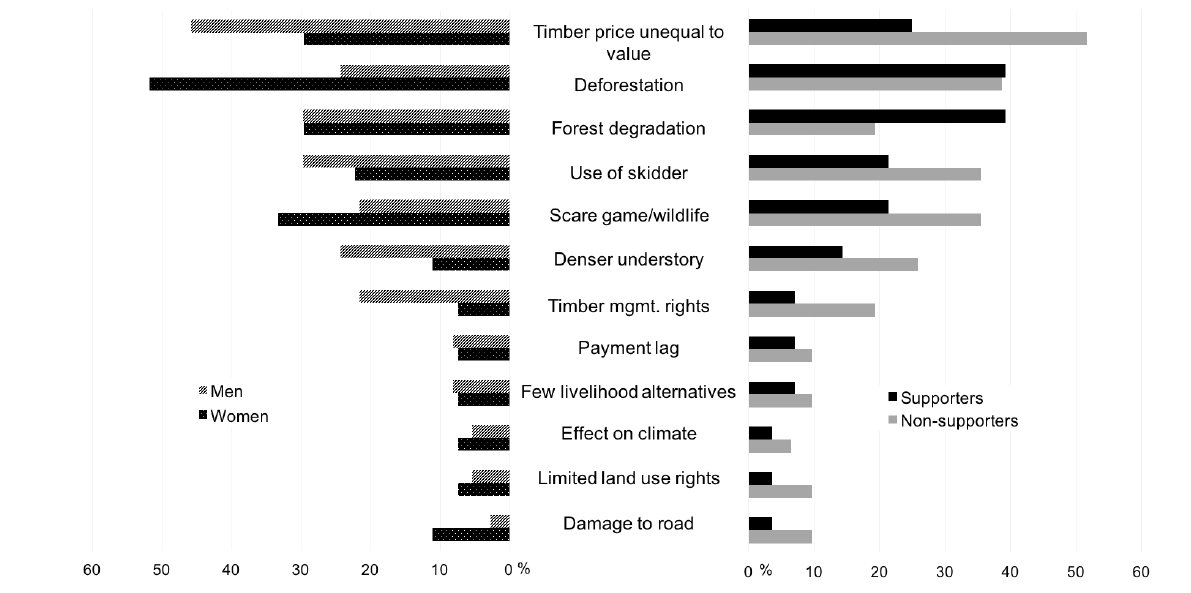
Fig. 3. Free list results comparing negative perceptions of the logging project between project supporters and nonsupporters and between men and women in Chico Mendes Extractive